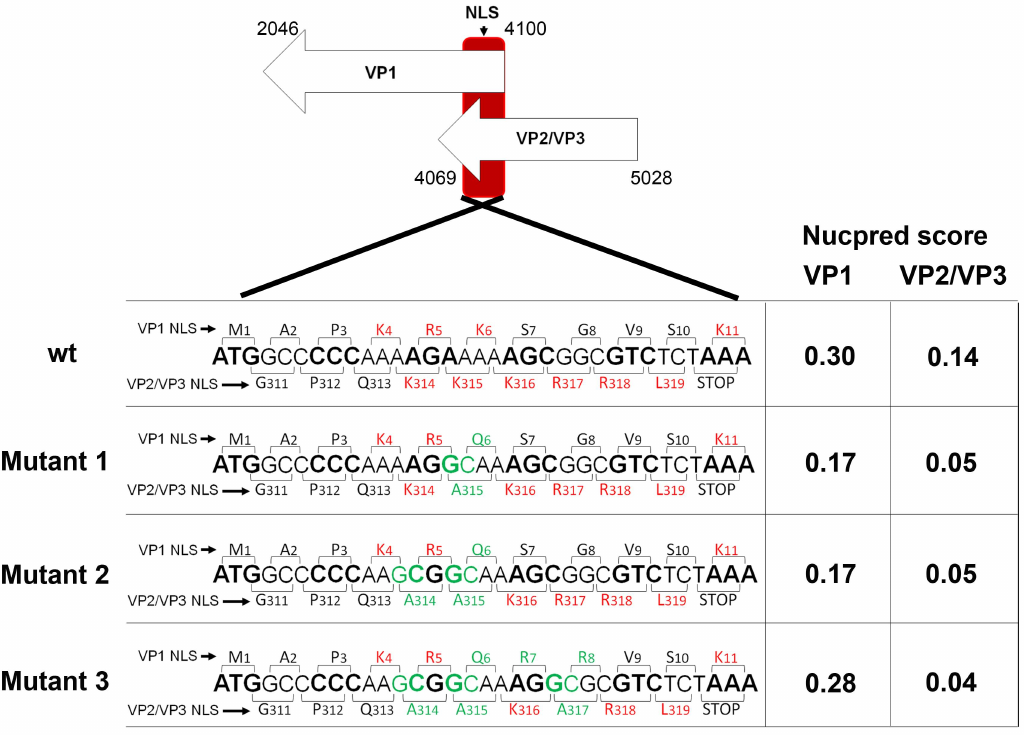
Figure 3. Mutagenesis design. Wild type MPyV overlapping coding sequences for VP1 and VP2/3 genes are displayed with the corresponding aa at the top of the nucleotide triplet for VP1 or at the bottom of the nucleotide sequence for VP2/3 (brackets show the codons). Positions of aa residues are given for VP1 (top) and VP2 (bottom) proteins, respectively. For better differentiation, codons for VP1 are alternate in bold and not bold letters. Mutants 1, 2, and 3 are also presented. For better display, the basic aa (K and R) are shown in red and the mutated nucleotides and corresponding aa are shown in green. NucPred score values for NLS of VP1 and VP2/3 capsid proteins of the wt or mutated variants are presented on the